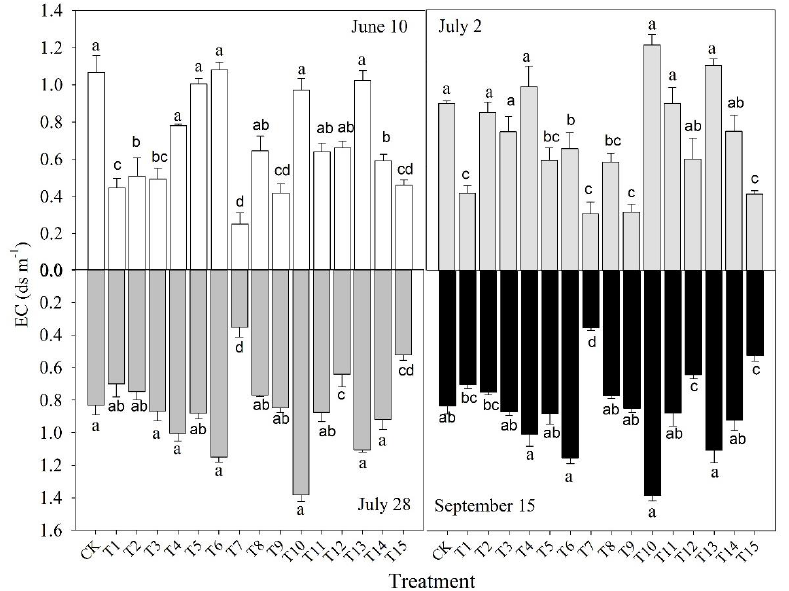
Figure 3. The average value of electrical conductivity (EC) during different maize growth periods of every third treatment plot. The EC was measured in a soil–water (1:5 w / w ) solution, using an EC meter (EC 215 conductivity meter, HANNA, Italy). Different letters indicate significant differences between treatments at the p < 0.05